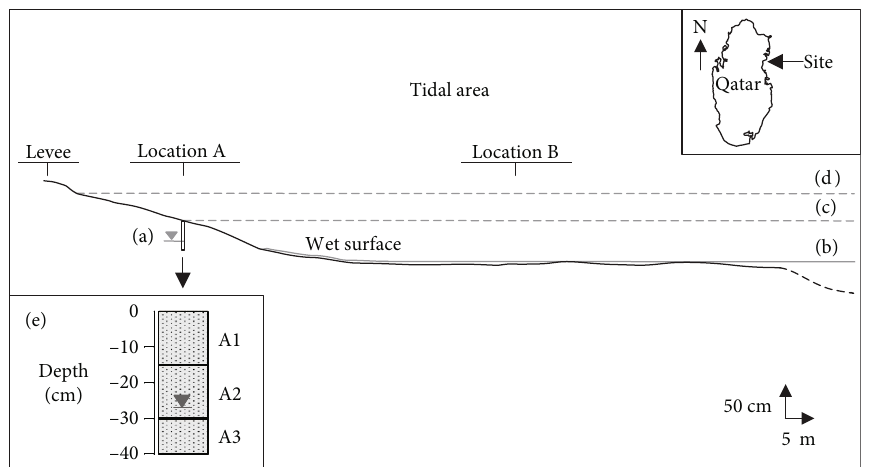
Figure 1: Schematic cross-sectional view of the sampling site between locations A and B. Elements with brackets indicate the following at the time of sampling: (a) the groundwater table, (b) the seawater level at low tide, (c) the normal high tide, and (d) the storm high tide. (e) The soil pro fi le at location A with depths of the soil samples A1, A2, and